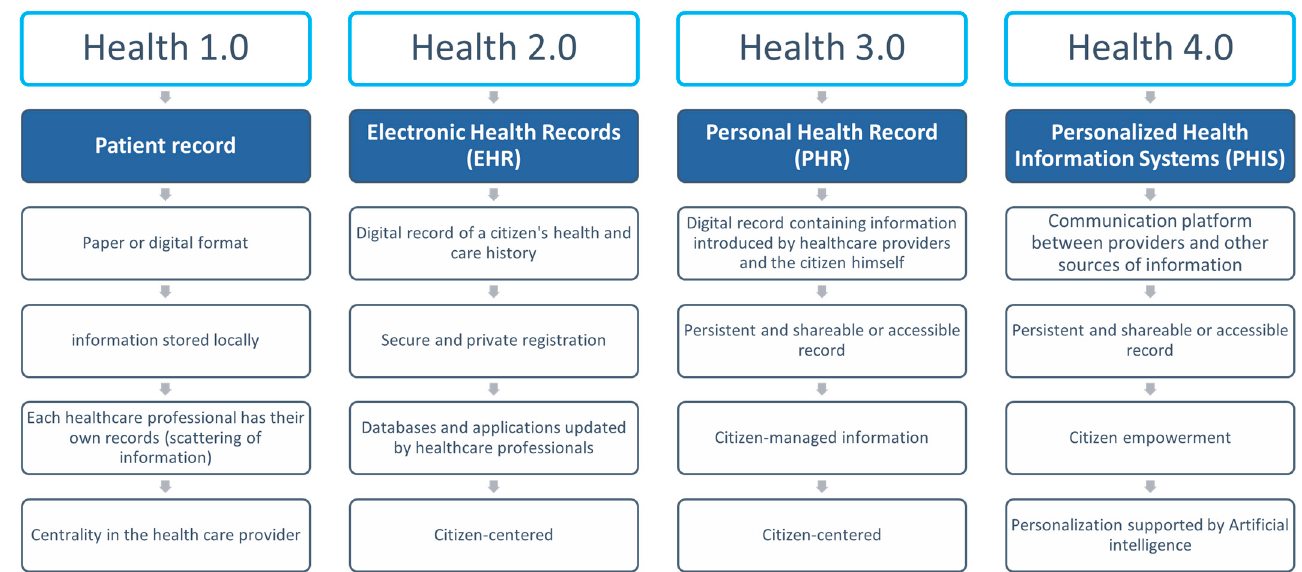
Figure 1. Evolution of HIS in health according to technological “eras”.